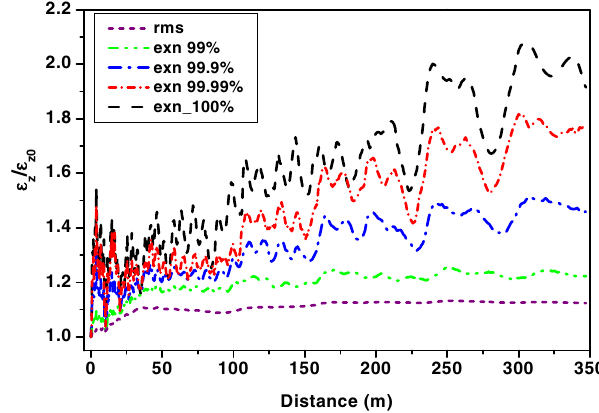
FIG. 25. Longitudinal emittance development along the main ¼ 0 : 85 , =" linac for different beam fractions for the working point situated z x at the resonance ( k